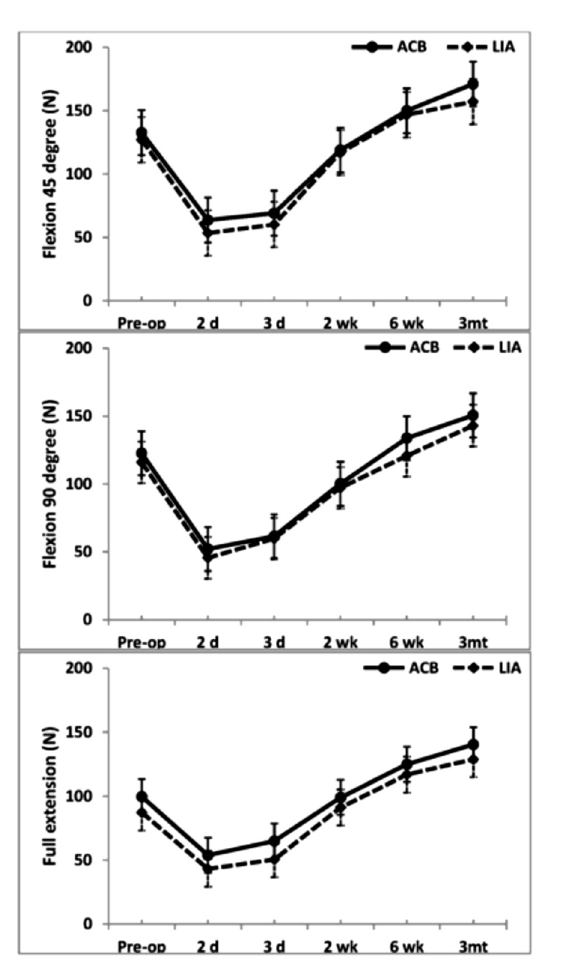
Quadriceps strength. Fig. 3: